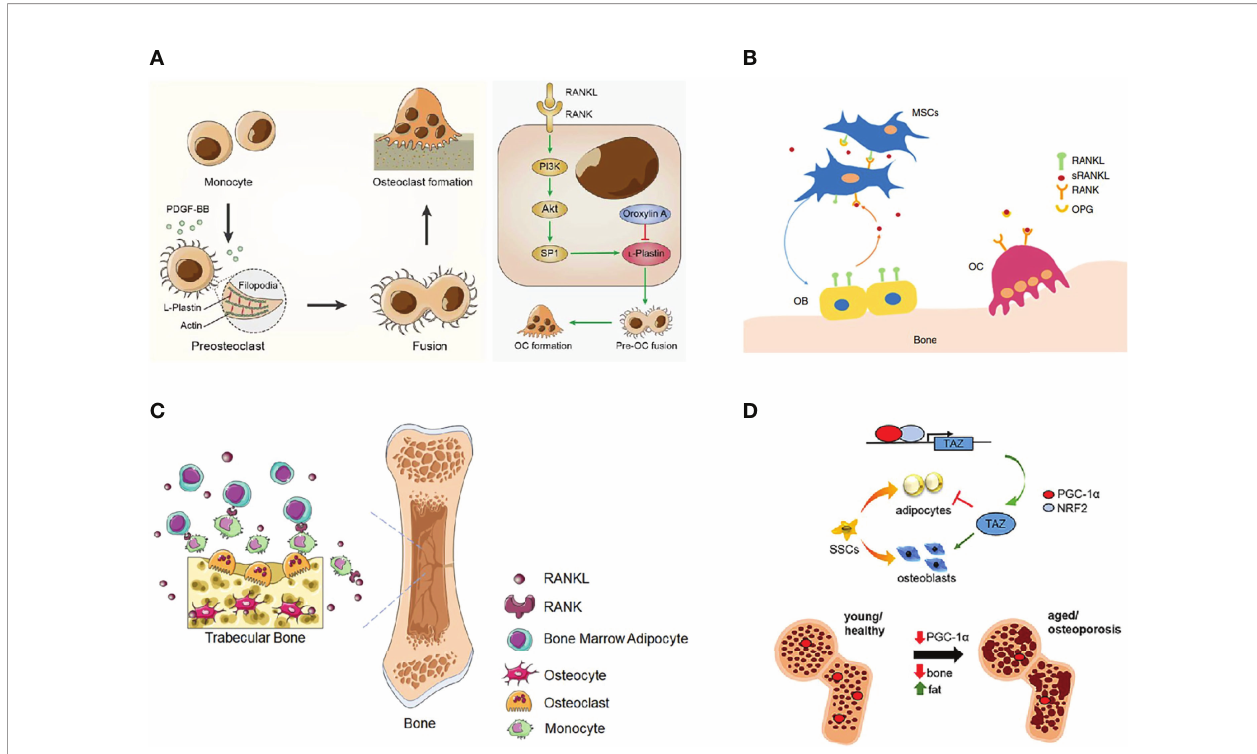
FIGURE 4 | Explore pathogenic mechanism of osteoporosis. (A) Targeting L-plastin prevents pre-osteoclasts fusion and promotes PDGF-BB secretion (35). (B) RANKL signaling inhibits osteoblastic differentiation of BMSCs (31). (C) Bone marrow adipocyte-derived RANKL controls trabecular osteoclastogenesis (66). (D) PGC-1 a controls skeletal stem cell fate and bone-fat balance in osteoporosis and skeletal aging